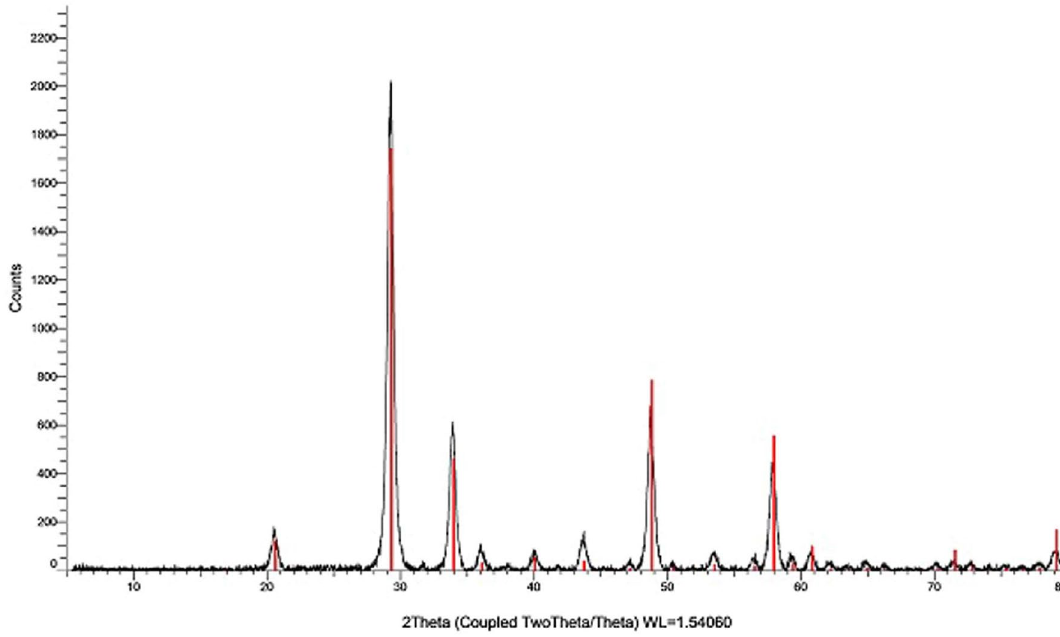
Figure 1. XRD pattern of Erbium Oxide